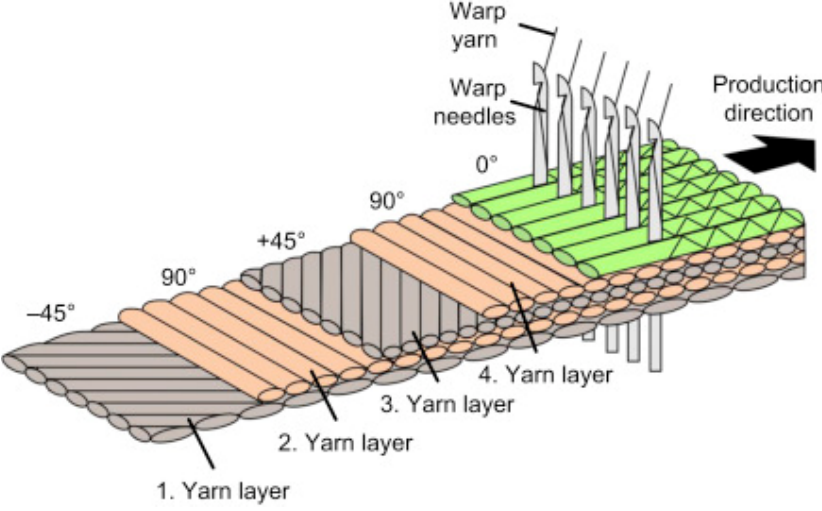
Figure 4 . ( a ) PVC core located inside the mould, ( b ) Prepreg sheet laminated the core and fitted inside the mould.